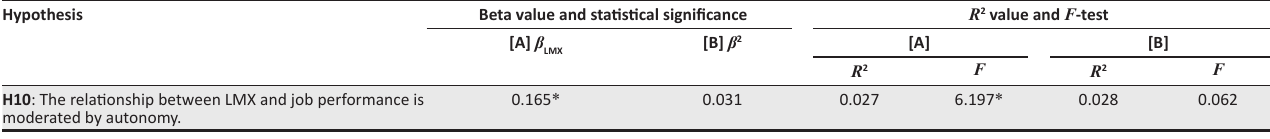
TABLE 7: Results of the moderated regression analyses.